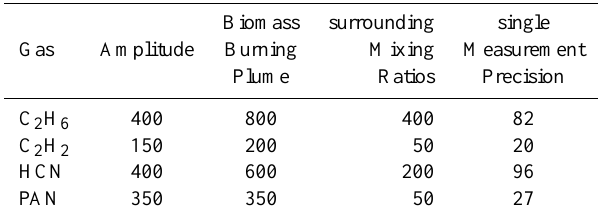
Table 5. Amplitude of local variability at 12km altitude versus single profile precision as a measure of detectability. All values are given in pptv.